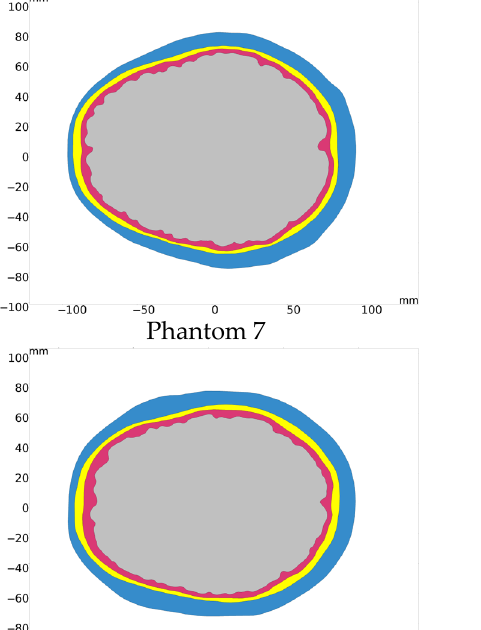
reductions for different numbers of frequency points.